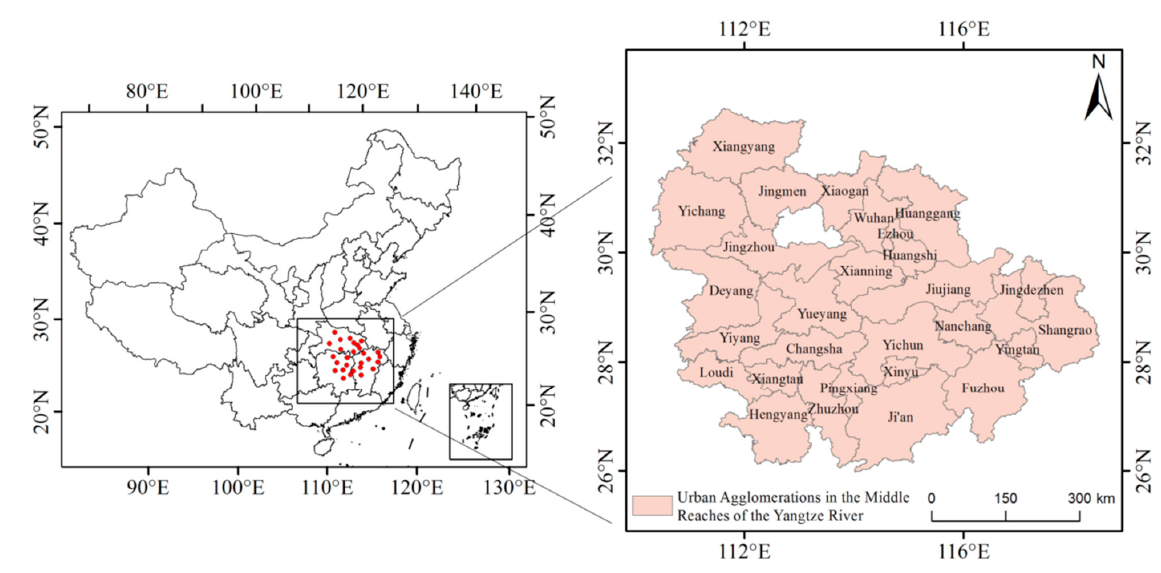
Figure 1. The urban agglomerations in the middle reaches of the Yangtze River.